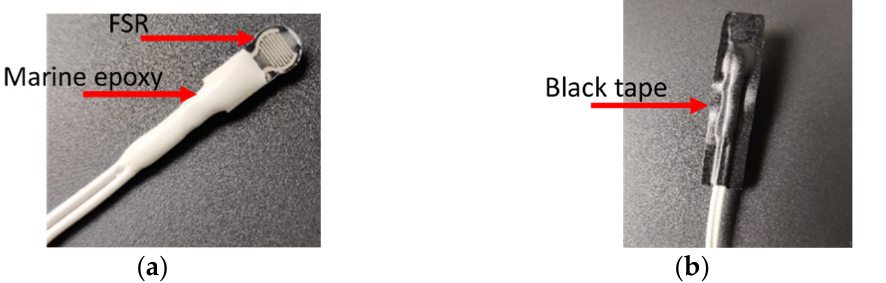
Figure 6. Waterproofed FSR: ( a ) FSR wires coated by marine epoxy; ( b ) FSR covered by black electrical tape.